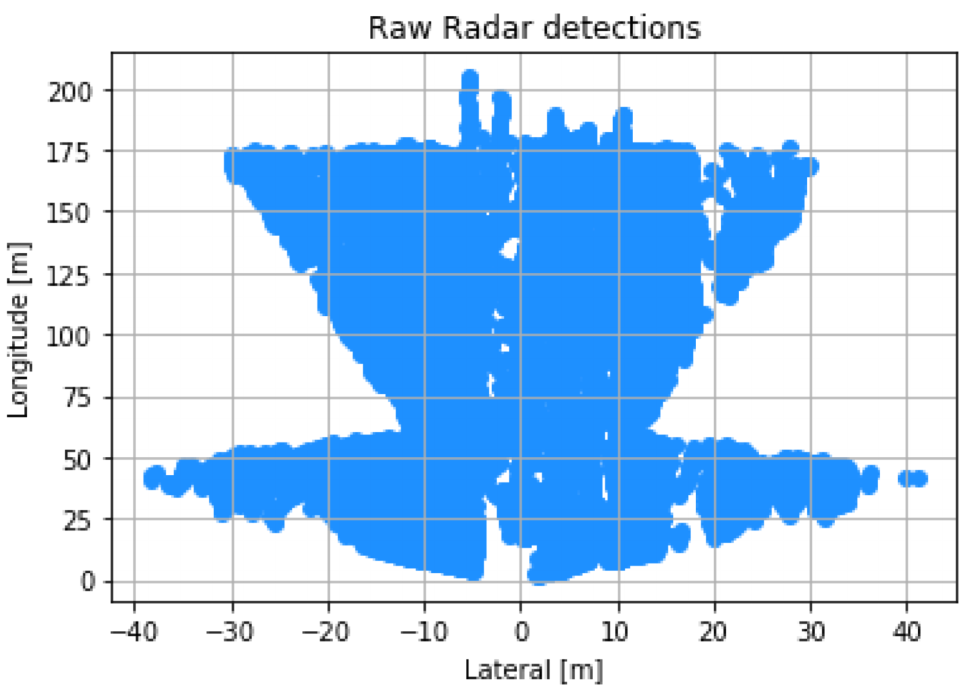
Figure 19. Radar distance validation. The plot shows detection over a driver cycle around WMU’s engineering campus, which includes highway